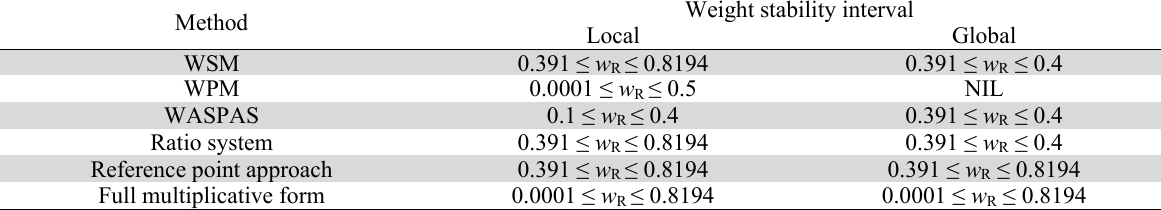
Single dimensional weight stability intervals for Example 2